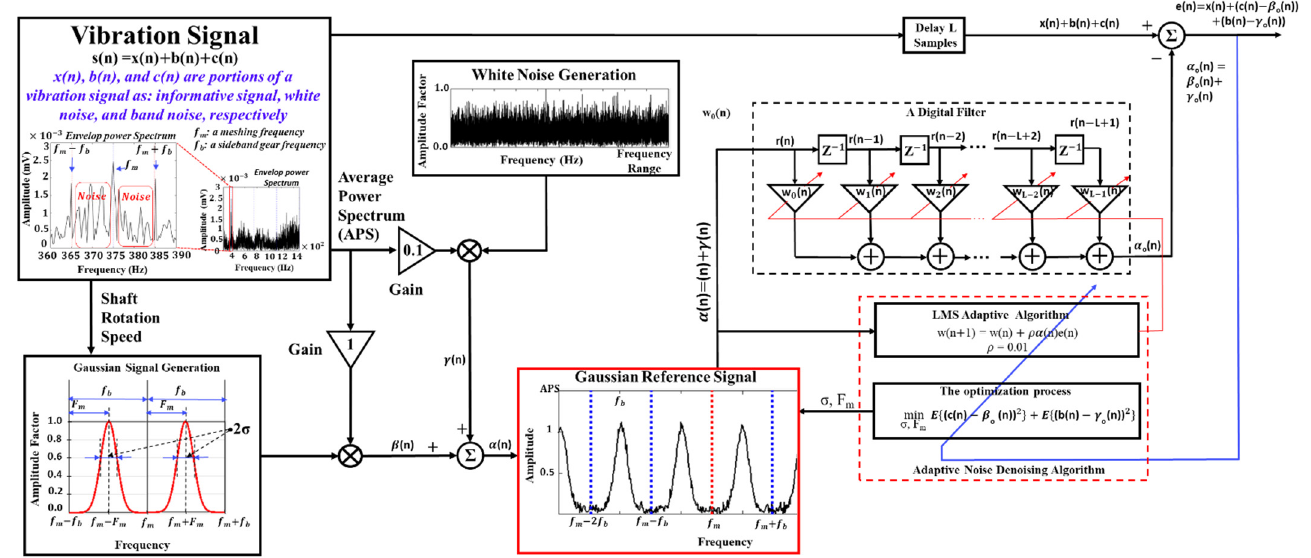
Figure 2. Schematic diagram of the ANR-GRS module.